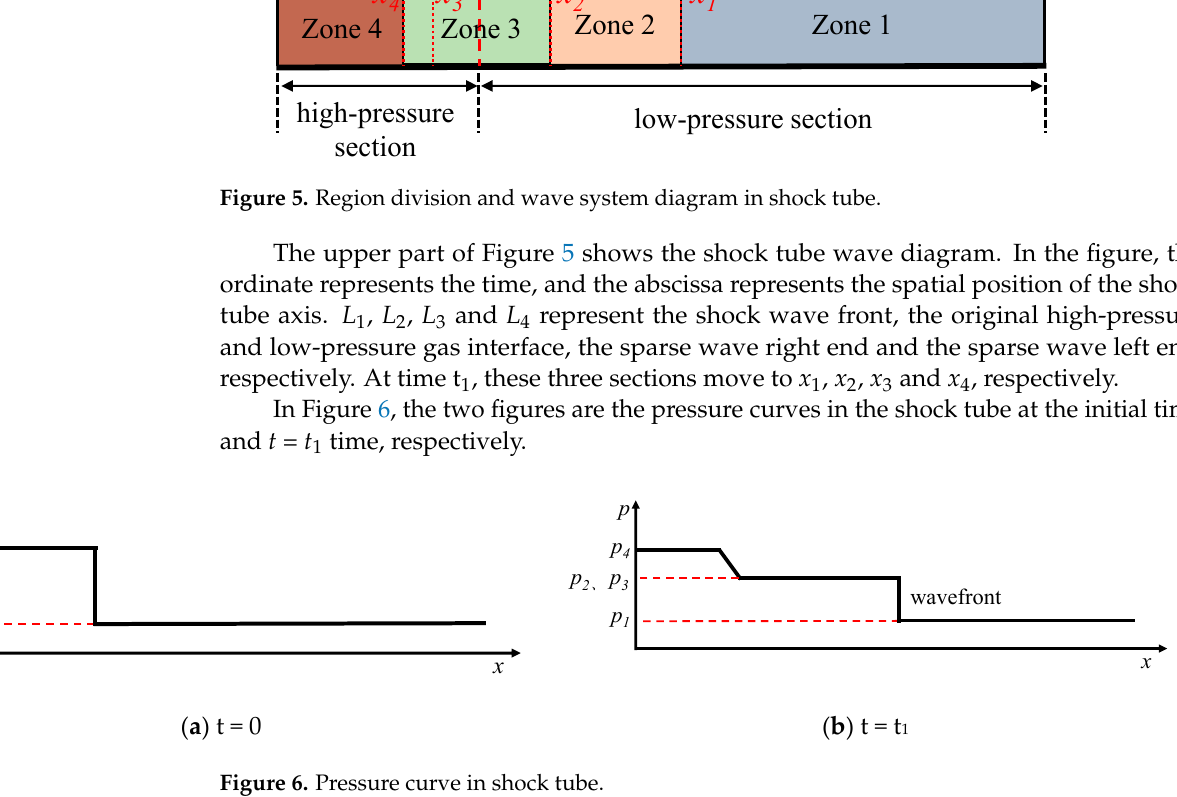
Figure 6. Pressure curve in shock tube.